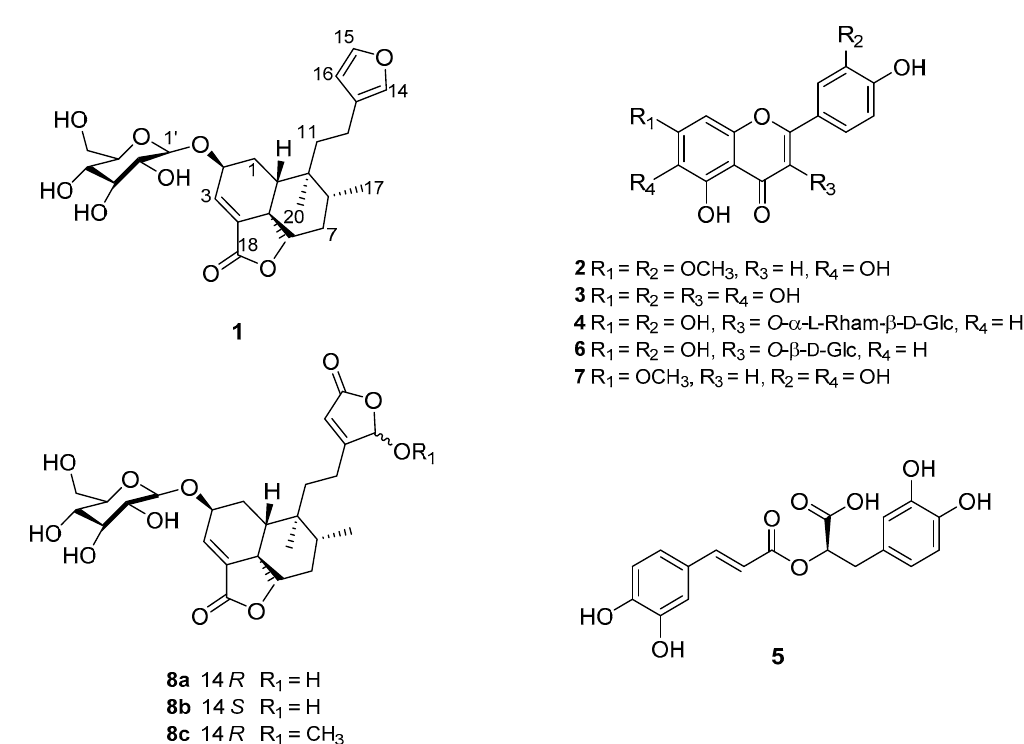
Figure 1. Structures of compounds ( 1 – 8a , b ) from S. amarissima.